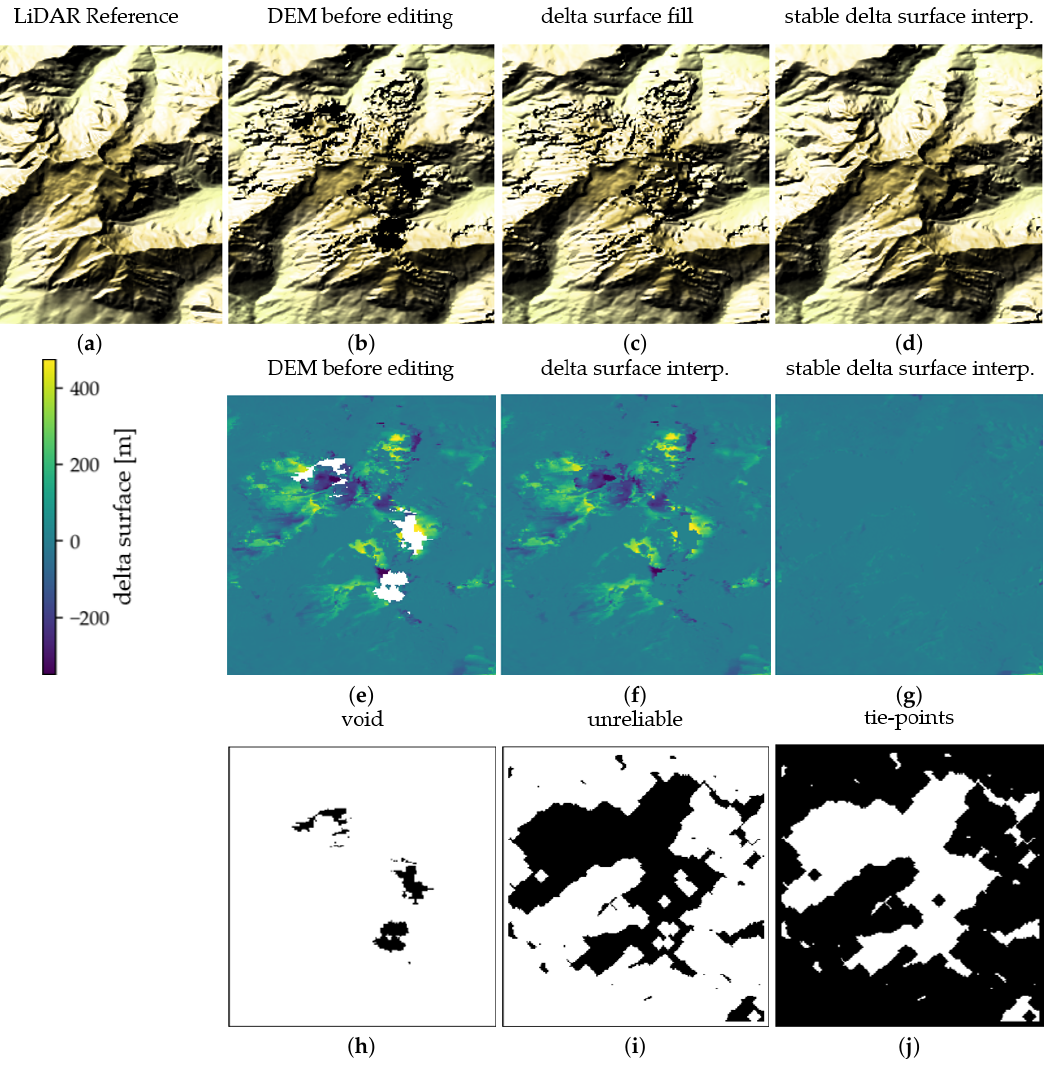
Figure 7. Example of the stable delta surface interpolation. ( a ) LiDAR reference DEM, ( b ) TanDEM-X DEM before editing, ( c ) TanDEM-X DEM after delta surface interpolation, and ( d ) after stable delta surface interpolation. ( e ) delta surface with respect to the LiDAR for the unedited TanDEM-X DEM, ( f ) delta surface for the delta surface interpolation, ( g ) delta surface for the stable delta surface interpolation, ( h ) input TanDEM-X voids (black), ( i ) unreliable pixels (black), and ( j ) tie-points